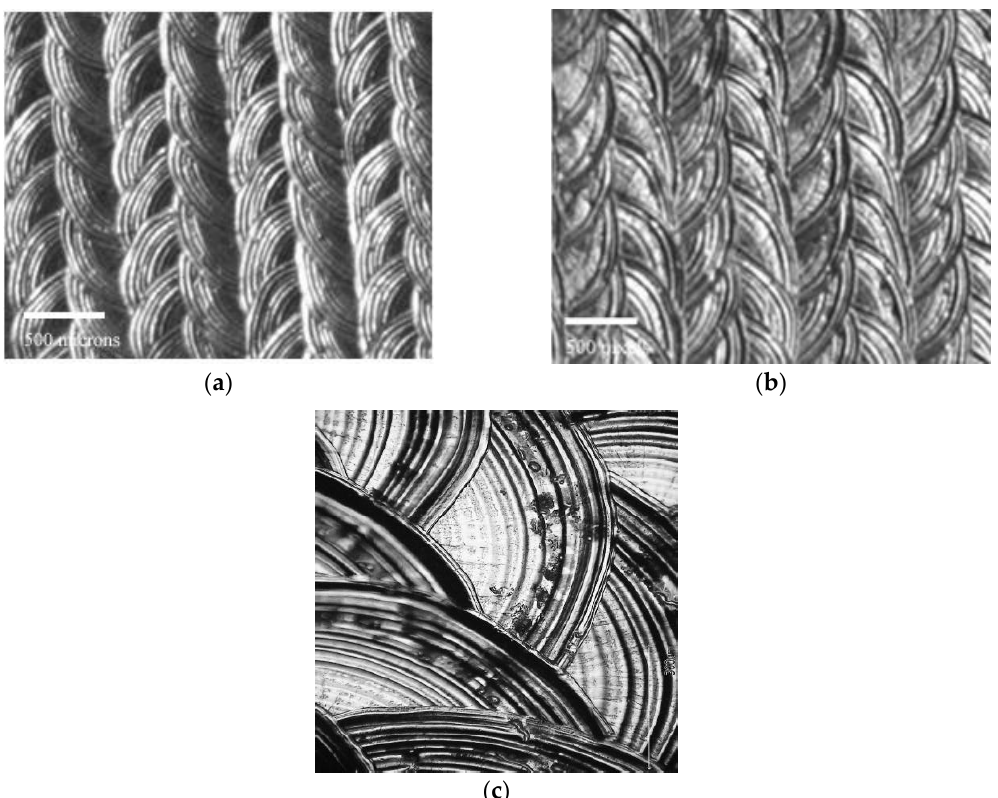
Figure 6. Surface features of the re-melted layers for different laser pulse power. ( a ) Surface topography of the sample re-melted with 2200 W laser pulse power; ( b ) Surface topography of the sample re-melted with 2600 W laser pulse power; and ( c ) magnified image of the surface topography of the sample re-melted with 2600 W laser pulse power.